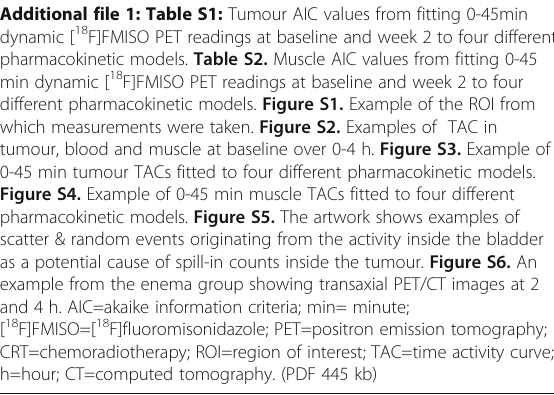
dimensionless) and β 2 (unit: dimensionless) were the partial volume and spill-in correction factors.